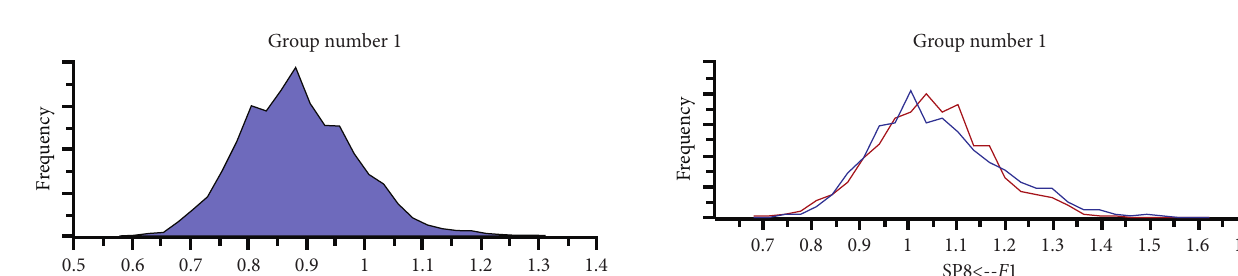
Figure 6: Bayesian diagnostic SP9.